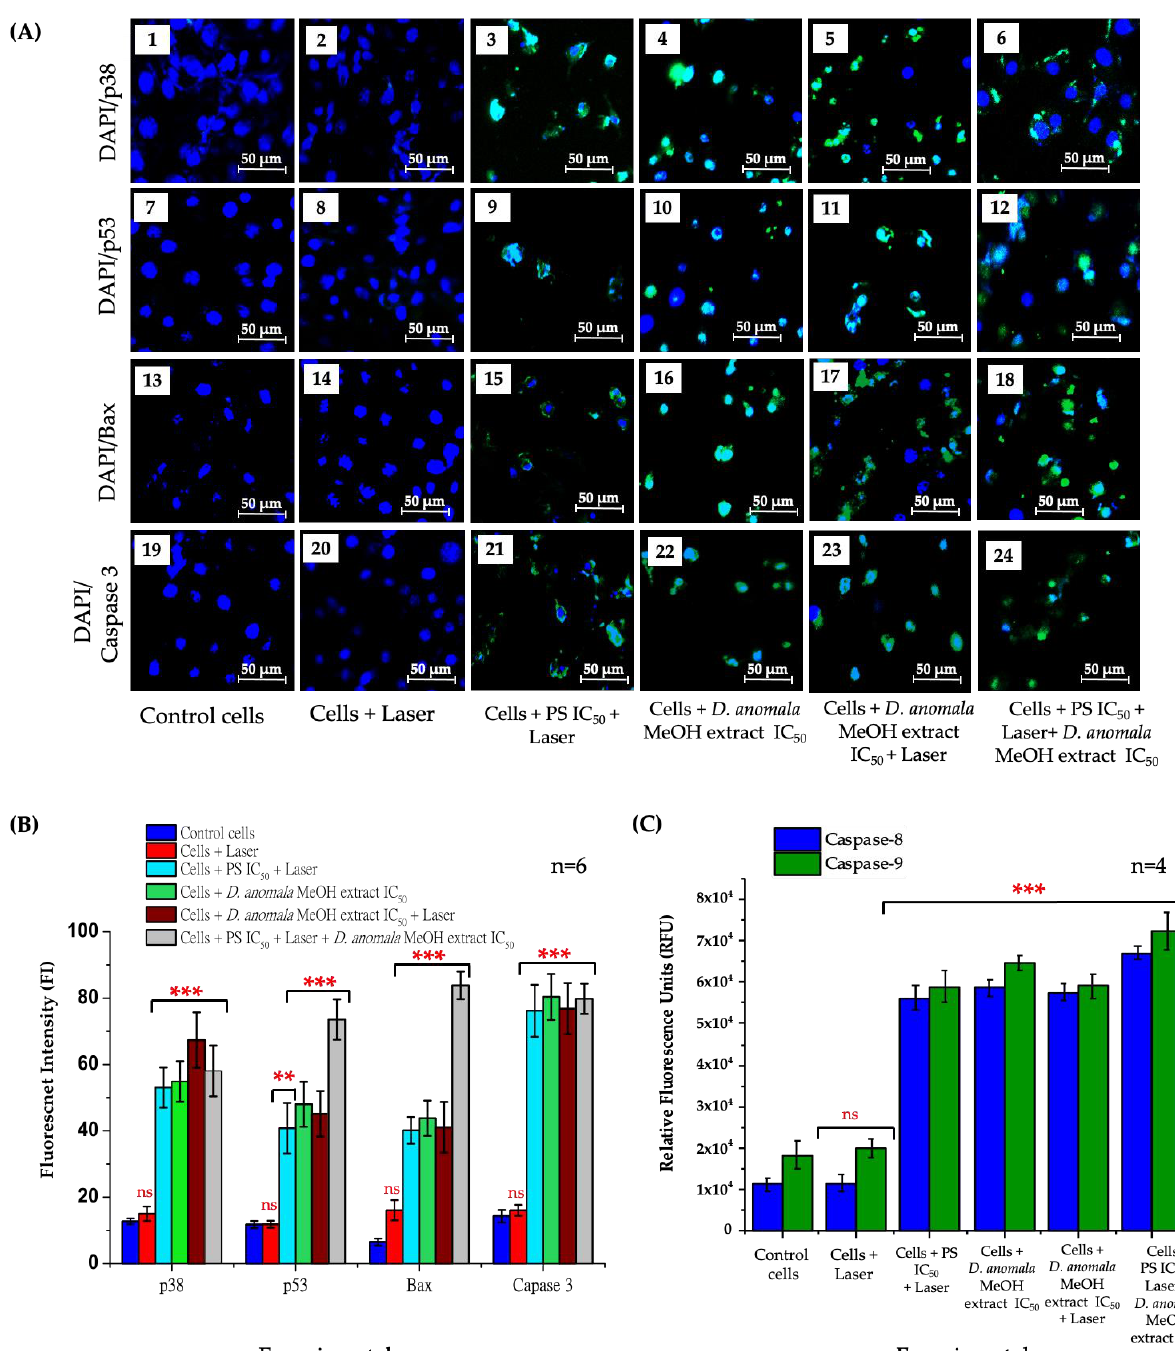
Figure 9. Apoptotic proteins (p38, p53, Bax, and caspase 3) visualization ( A ), mean fluorescent quantification ( B ) post-treatment with ZnPcS 4 -mediated PDT IC 50 and D.A MeOH extract IC 50 , and the fluorometric multiplex activities of caspase 8 and 9 ( C ). Blue fluorescence (DAPI) stains the nucleus, and green fluorescence (FITC) represents the expression of apoptotic proteins. No expression of apoptotic proteins in A549 laser-treated cells ( 2 , 8 , 14 , 20 ). Increased expression of apoptotic proteins in A459 cells treated with ZnPcS 4- mediated PDT ( 3 , 9 , 15 , 21 ), cells treated with D.A MeOH extract IC 50 ( 4 , 10 , 16 , 22 ), A549 cells treated with D.A MeOH extract IC 50 + laser irradiation ( 5 , 11 , 17 , 23 ), and cells treated with ZnPcS 4- mediated PDT + D.A MeOH extract IC 50 ( 6 , 12 , 18 , 24 ). (200× magnification and scale bar: 50 μm) ( A ). The values depicted in ( B , C ) are mean ± standard errors. Significant mean differences of independent treatments are represented as ** p < 0.01, and *** p < 0.001.